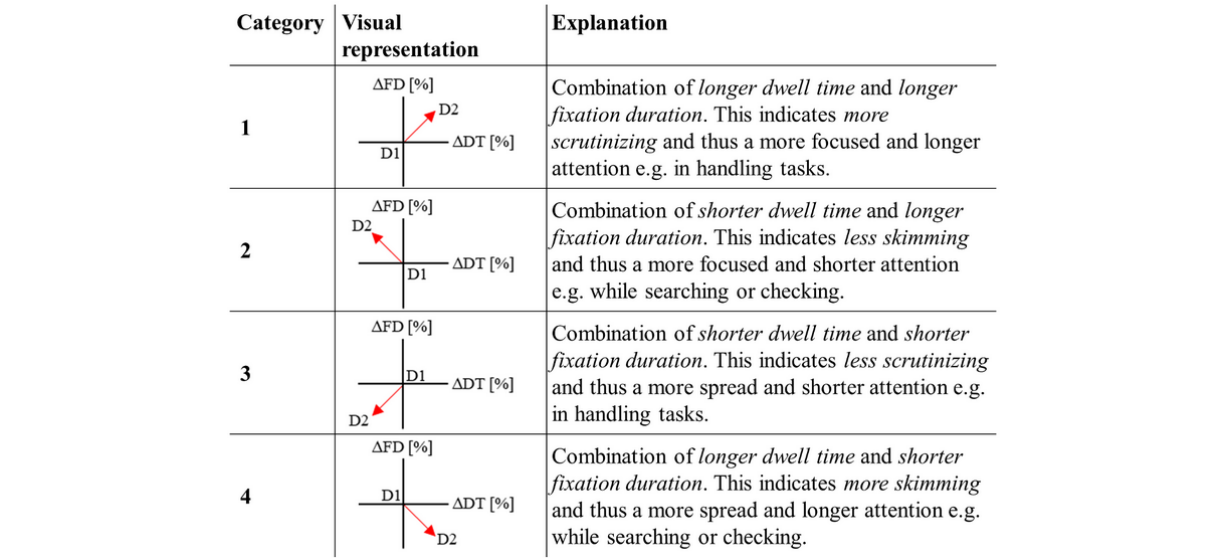
Figure 3. Visualization of shifts in two dimensions of the physiological gaze data measurements fixation duration and dwell time. The displayed shifts are from a Design D1 in the coordinate origin to a Design D2, presented in the middle column. In total, a distinction is made between the four categories. The right column explains the four patterns.